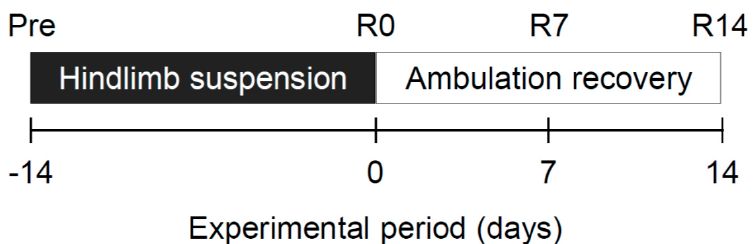
Figure 1. Summary of the experimental protocol. The hindlimbs of both dominant-negative mutant of AMPK (AMPK-DN) and wild-type littermate (WT) mice were continuously suspended for 14 days. After 14 days, the mice were allowed ambulation recovery. Pre: before hindlimb suspension; R0, R7, and R14: 0, 7, and 14 days after ambulation recovery; n = 8 per group.